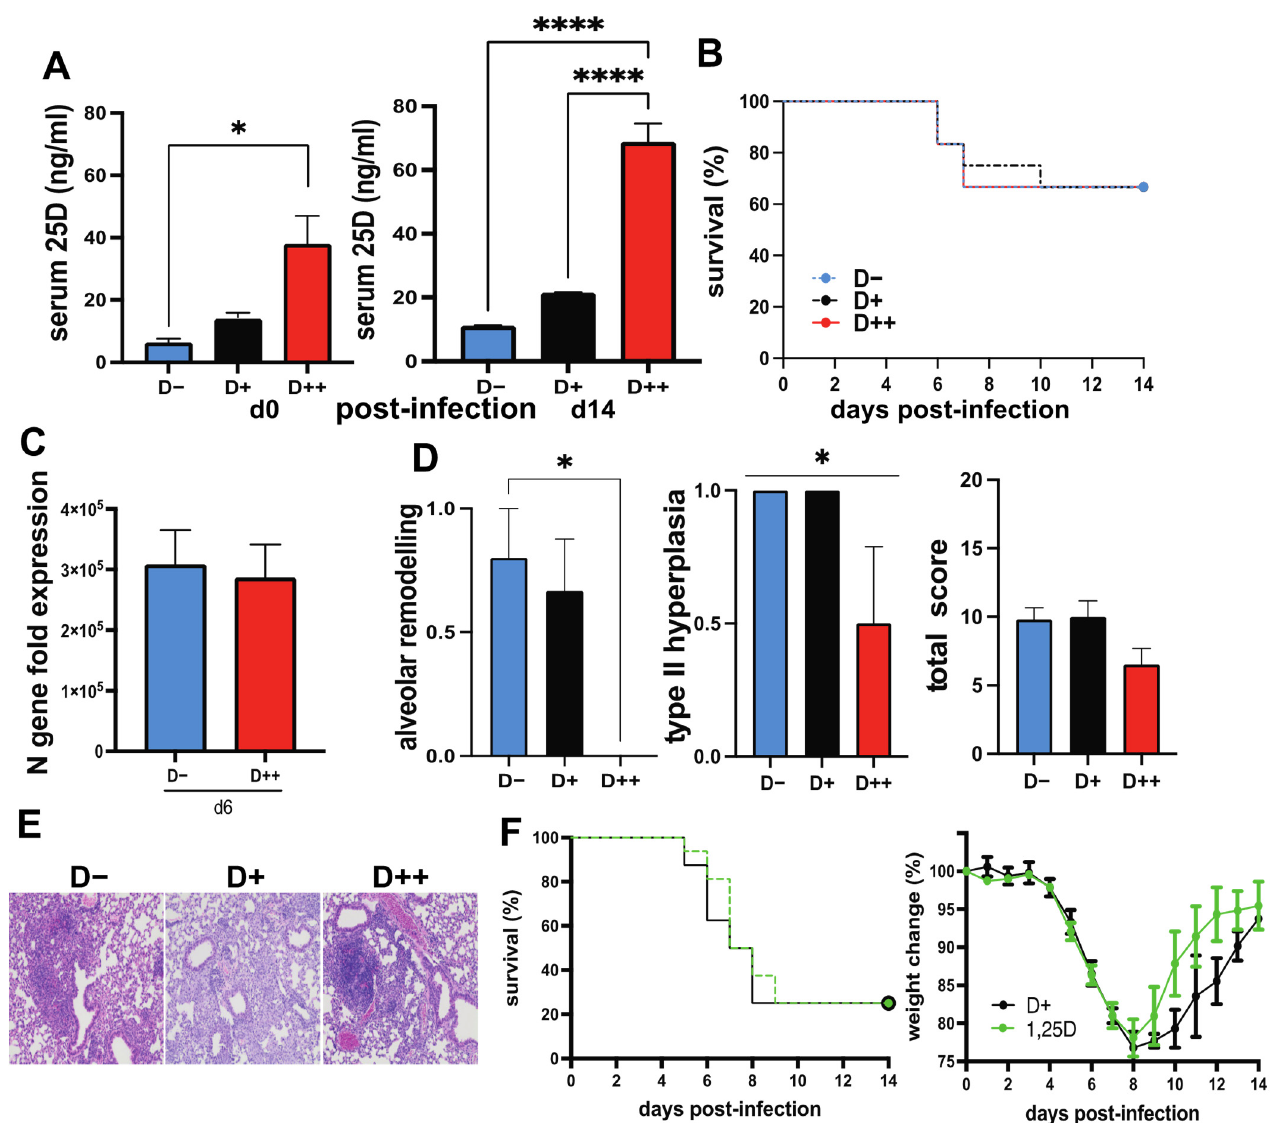
Figure 3. High dose vitamin D reduces lung inflammation following SARS-CoV-2 infection. hACE2 mice were fed vitamin D deficient (D − , n = 18), vitamin D sufficient (D+, n = 12), or vitamin D supple- mented (D++, n = 18) diet and infected with 200 TCID 50 SARS-CoV-2. ( A ) Serum 25D was measured before and at day 14 post-infection, and ( B ) the survival of D − , D+, and D++ mice. ( C ) SARS-CoV-2 N gene expression in the lungs ( n = 6 mice/group) at day 6 post-infection. Gene expression relative to uninfected D+ controls. ( D ) Alveolar remodeling, type II pneumocyte hyperplasia, and total histology score in D − , D+, and D++ mice ( n = 4–6 mice/group) at day 14 post-infection. ( E ) Representative histology images for D − (score = 9), D+ (score = 11), and D++ (score = 5). D+ hACE2 ( n = 8) mice at day 14 post-infection. 1,25(OH) 2 D (1,25D)-treated D+ hACE 2 ( n = 16) mice were infected with 1000 TCID 50 SARS-CoV-2. ( F ) Survival and body weight change over the course of infection. Values are the mean ± SEM. Statistical significance was assessed using one-way ANOVA with Bonferroni multiple comparison test for ( A , D ), log rank (Mantel–Cox) test for each of the groups for ( B , F ), unpaired t -test on log-transformed expression values for ( C ), and two-way ANOVA with Bonferroni multiple comparison test for ( F ). * p < 0.05 and **** p <